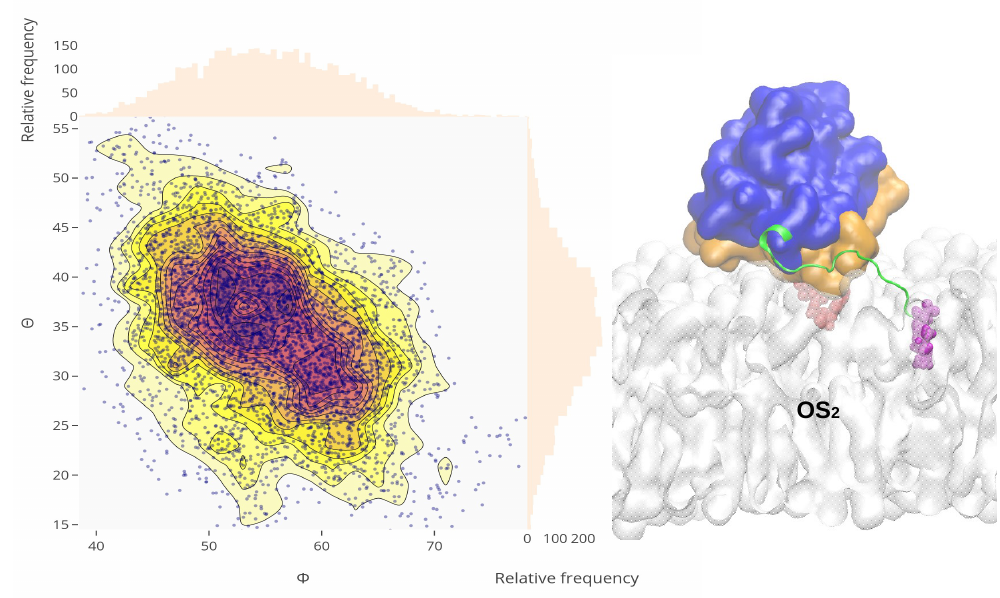
Figure A5. Orientation of the wild-type KRas-4B-Far on the anionic chol.-30% membrane. Colors defined as Figure